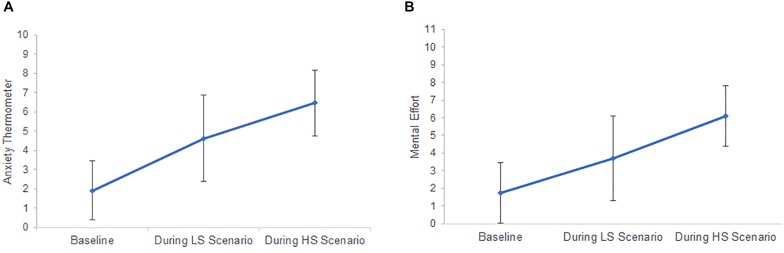
Psychological response profiles to the low stress (LS) and high stress (HS) scenario regarding mean anxiety (A) and mean mental effort (B). Error bars represent standard deviation.